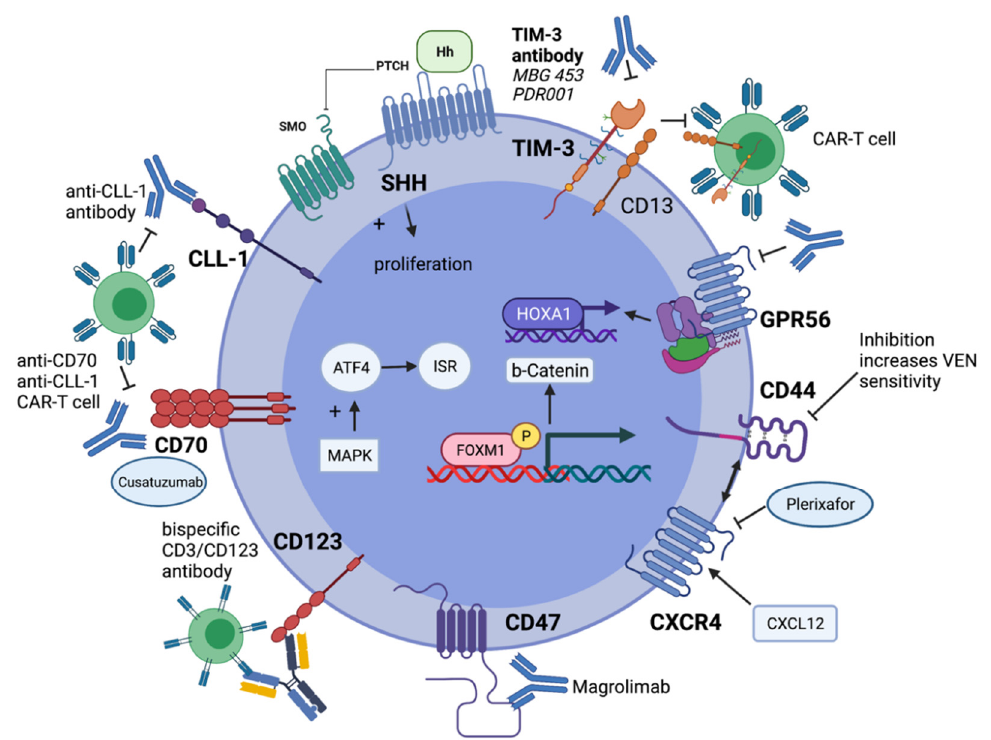
Figure 2. Current immunotherapeutic approaches targeting leukemic stem cells in AML patients. TIM-3 is a membrane bound glycoprotein and immunoreceptor expressed on both LSCs and cytotoxic CD4 + and CD8 + T-cells. It can be addressed by monoclonal antibodies (MB453 or PDR001) and bispecific directed CAR-T cells against CD13 and TIM-3 . GPR56 , a G- protein coupled transmembrane receptor, can be overexpressed in LSCs causing upregulation of leukemia driving tran- scription factor HOXA1 . CD44 is an adhesion molecule, which physically interacts with the transmembrane protein CXCR4 and activated by CXCL12, which is crucial for anchorage of LSCs in the bone marrow niche. Inhibition of CD44 overcomes resistance to BCL-2 inhibitor venetoclax whereas CXCR4 can directly be inhibited by plerixafor, leading to mobilization of LSCs from the bone marrow niche [197]. CD47 is an integrin associated membrane protein and able to suppress macro- phages and thus preventing eliminating of LSCs. The CD47 directed monoclonal antibody magrolimab could disrupt the connection between CD47 on LSC and SIRPalpha on macrophages. CD123 as interleukin 3 receptor can be targeted by bispecific CD3/CD123 antibodies to redirect T-cell to LSCs. CD70 as a ligand of the TNF superfamily receptor CD27 can be hindered from binding by monoclonal antibody cusatuzumab or CD70 directed CAR-T cells. Same approaches are illus- trated for CLL-1 receptor. SHH and MAPK signaling is illustrated since they represent highly conserved pathways in LSCs which mainly contribute to maintenance and cell proliferation. MAPK is known to activate integrated stress response signaling which promotes cellular recovery and restore homeostasis. The transcription factor FOXM1 is crucial for main- taining, survival, and renewing of LSCs, which is activated by b -catenin/WNT signaling. Created with BioRender.com. Abbreviations: TIM-3 T cell immunoglobulin and mucin-domain containing-3; AML acute myeloid leukemia; LSC leuke- mic stem cell; CAR-T chimeric antigen receptor t cell; GPR56 adhesion G protein–coupled receptor 56; HOXA1 Homeobox A1; CXCR4 C-X-C chemokine receptor type 4; CXCL12 C-X-C chemokine ligand type 12; BCL-2 b-cell lymphoma-2; TNF tumor necrosis factor; CLL-1 C-type lectin domain family 12 member A; SHH sonic hedgehog; MAPK Mitogen-activated protein; FOXM1 Forkhead Box Protein M1; VEN Venetoclax. 11. Conclusions Cytogenetic, especially molecular genetic analysis of AML cells, at diagnosis and at relapse, is indispensable for risk stratification with respect to alloHSCT consolidation treatment, and to implement target therapies up-front. Treatment algorithms for elderly AML patients not eligible for intensive chemother- apy have been changed and the addition of venetoclax to epigenetic therapy has improved survival of elderly AML patients tremendously. Understanding the molecular mecha- nisms of primary or acquired resistance to venetoclax-based regimens in AML is of im- portance to improve second-line strategies for those patients not responding adequately